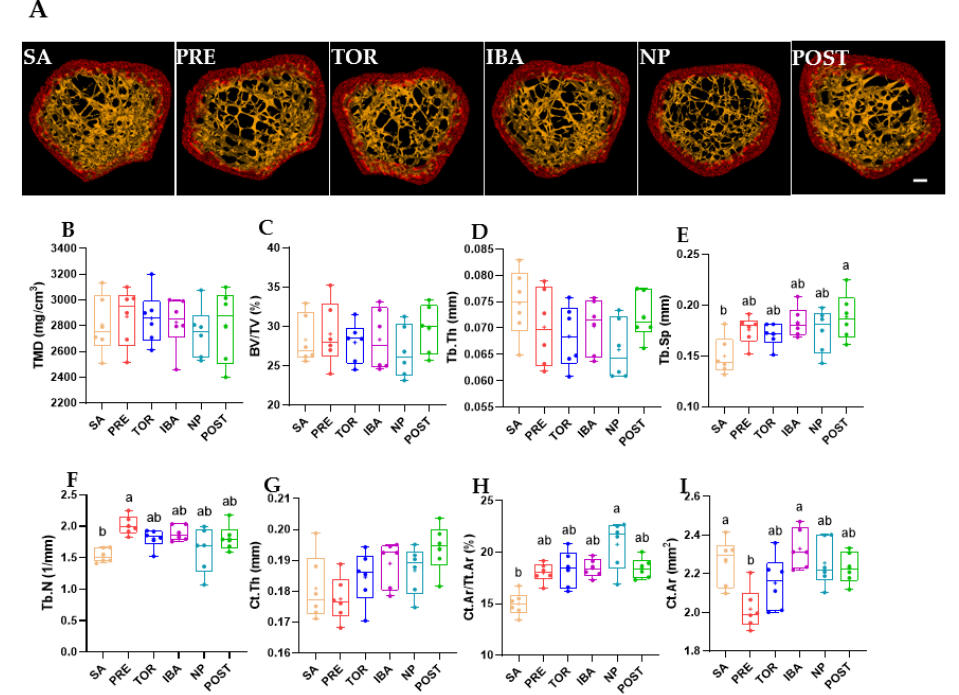
Figure 4. Changes in microstructural parameters of femur in different groups. ( A ) Representative micro-CT images of distal femur in different groups (Bar = 200 μm). Related parameters: X-ray tube potential of 50 kVp and tube curr ent of 80 μA in air. The captured images were acquired at a voxel size of 43 μm (filter: Cu 0.06 mm + Al 0.5 mm). Region of interest (ROI) was defined as the coronal central region of the distal femur (0.5 mm thick; number of slices: 512 layers). Histograms of micro- structural parameters, including ( B ) tissue mineral density (TMD, mg/cm 3 ), ( C ) bone volume frac- tion (BV/TV, %), ( D ) trabecular thickness (Tb.Th, mm), ( E ) trabecular separation (Tb.Sp, mm), ( F ) trabecular number (Tb.N, 1/mm), ( G ) average cortical thickness (Ct.Th, mm), ( H ) cortical area frac- tion (Ct.Ar/Tt.Ar, %), and ( I ) cortical area (Ct.Ar, mm 2 ) in distal femur of different groups. SA, sum- mer active group; PRE, pre-hibernation group; TOR, torpor group; IBA, interbout arousal group; NP, near post-hibernation group; and POST, post-hibernation group. Boxes represent upper and lower quartiles, middle horizontal line represents median, plus sign represents average, lines ex- tending from upper and lower ends represent upper and lower edges, respectively, and points rep- resent individual sample values ( n = 6). Superscripts with different letters indicate significant dif- ferences ( p < 0.05) among groups by Sidak test. Superscripts with same letter or no superscripts denote no significant differences ( p > 0.05).